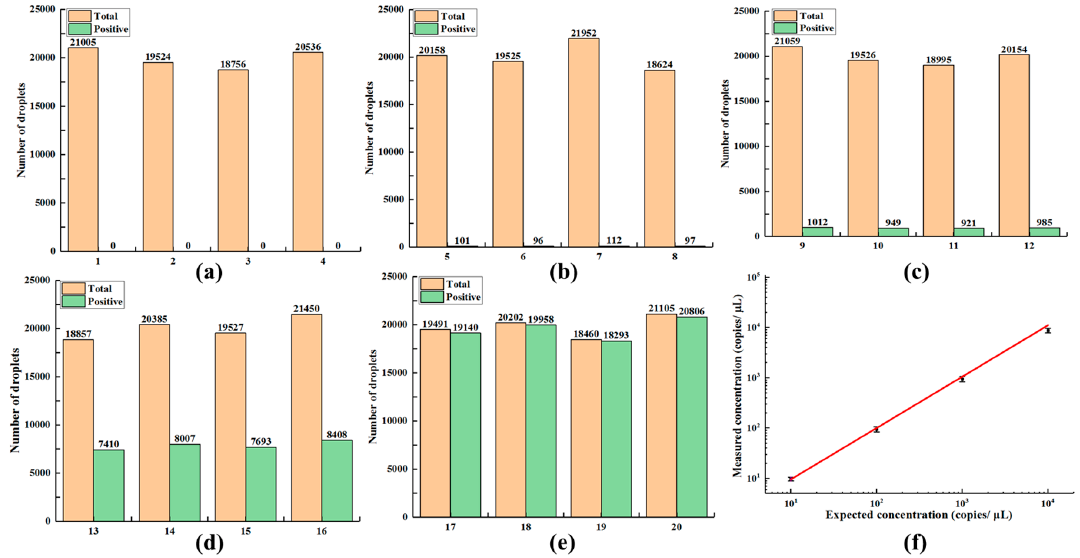
Figure 10. Verification results of digital LAMP. ( a ) Statistics of droplets for negative control. ( b – e ) Droplet statistics for serially-diluted DNA samples. ( f ) Linear relationship between measured values (copies/ μ L) by the digital LAMP chip and the expected copy number per reaction. Four tests were performed for each data point.